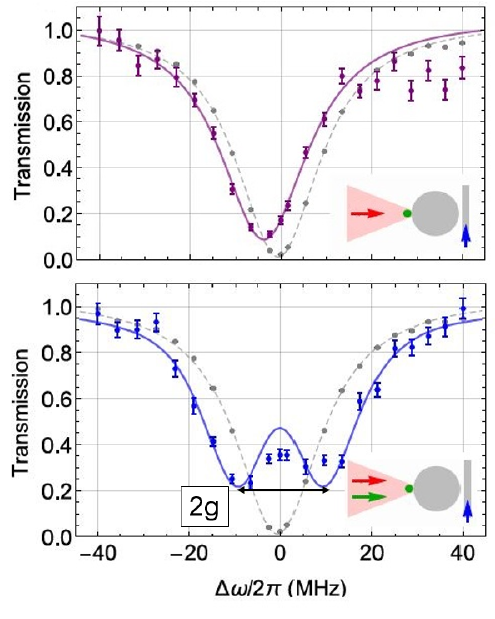
Figure 2. Transmission spectra of the coupled atom-resonator system. In violet (above): without LSC. In blue (below): with LSC. In grey: transmission spectrum of the empty resonator. The solid lines represent the theoretical